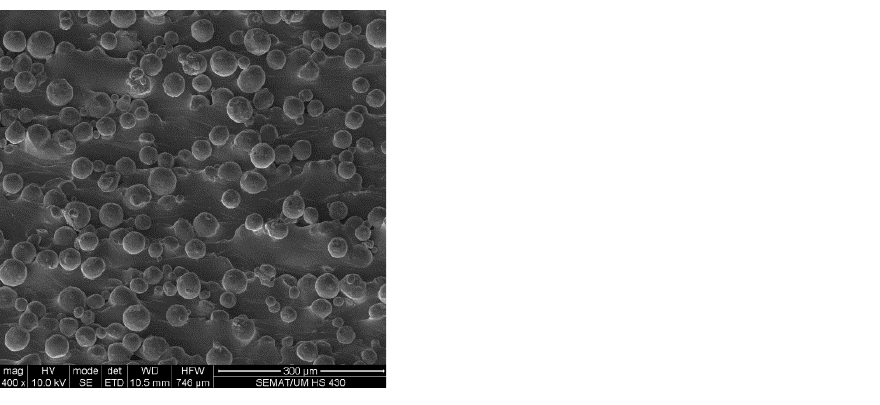
Figure 6. Outer wall of a thin-walled tube built in experiment number 9 (80 W/300 mm/s). The average results of the measurements performed on the thin-walled tubes (i.e., melt thickness, total thickness, and hole width) are shown in Figure 7.